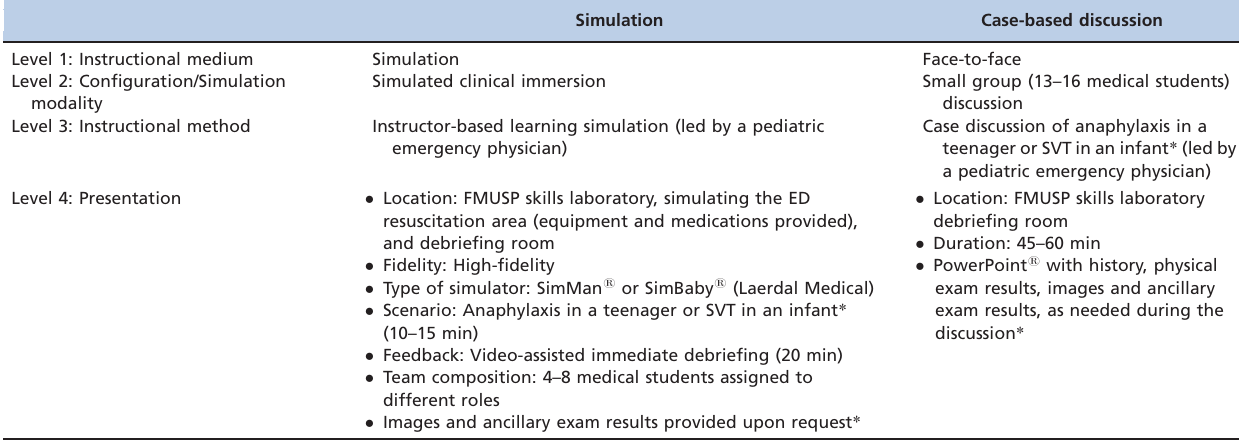
Table 1 - Comparison of the instructional design for the two